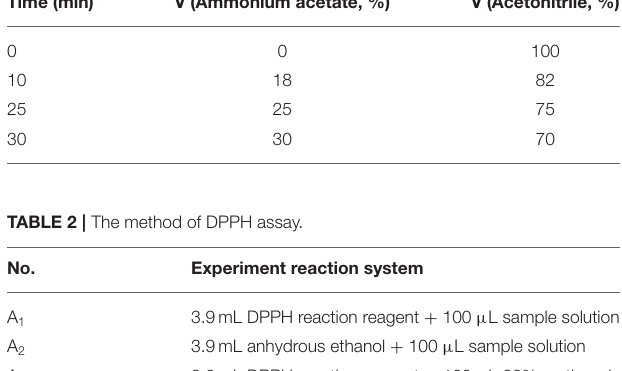
TABLE 1 | Mobile phase gradient elution procedure. Time (min)